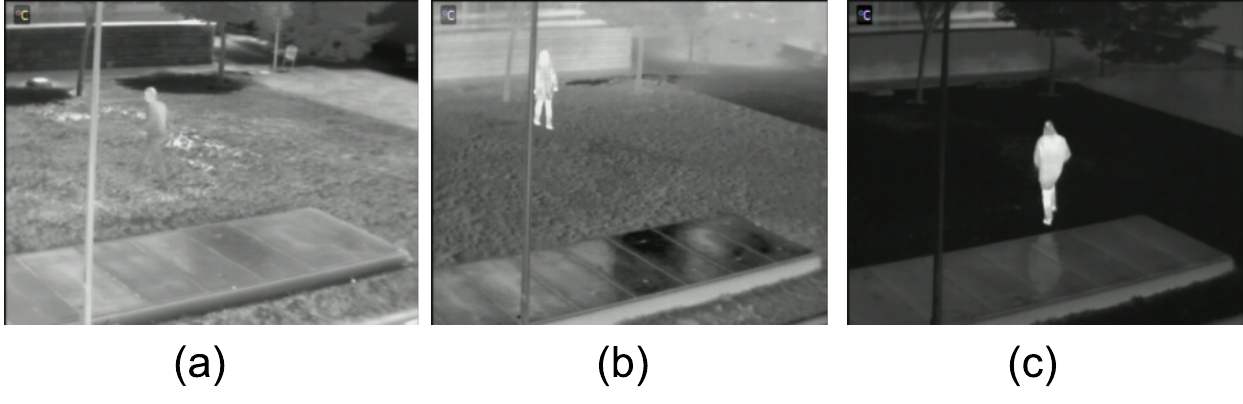
Figure 3. Different confidence values for the thermal infrared spectrum. ( a ) Thermal infrared image with a low confidence value; ( b ) thermal infrared image with a medium confidence value; ( c ) thermal infrared image with a high confidence